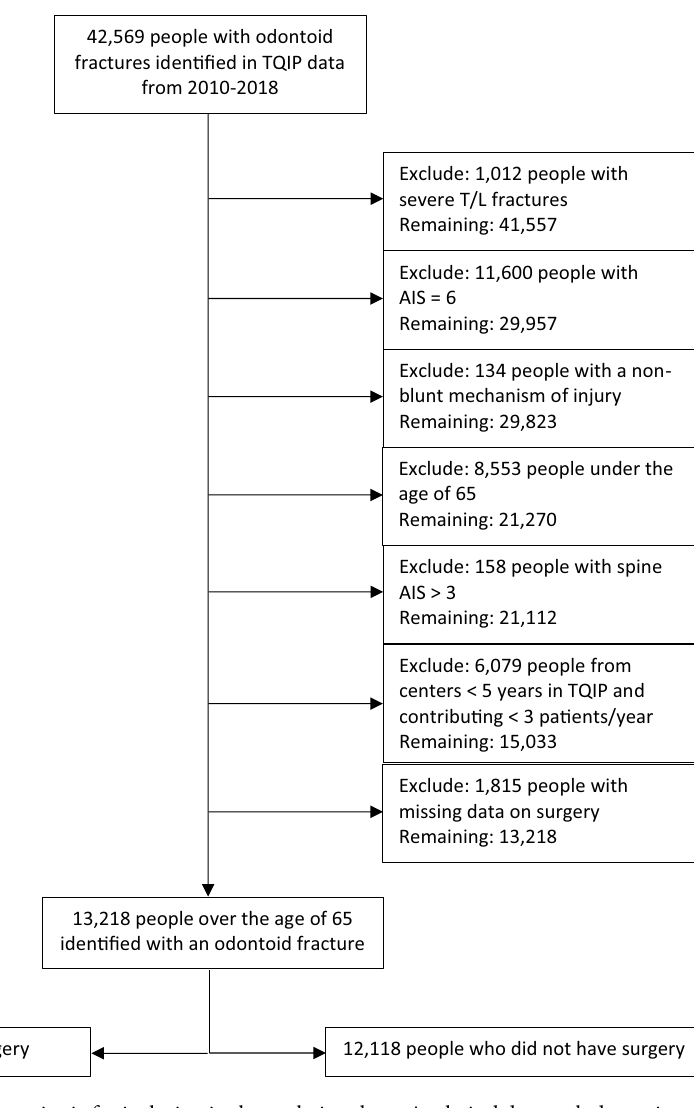
Figure 1. Flow diagram depicting criteria for inclusion in the analytic cohort. Analytical data excludes patients from centers contributing one patient or less. AIS Abbreviated injury scale, TQIP Trauma quality improvement program, T/L Thoracolumbar. This figure is original to this submission so no credit or license is